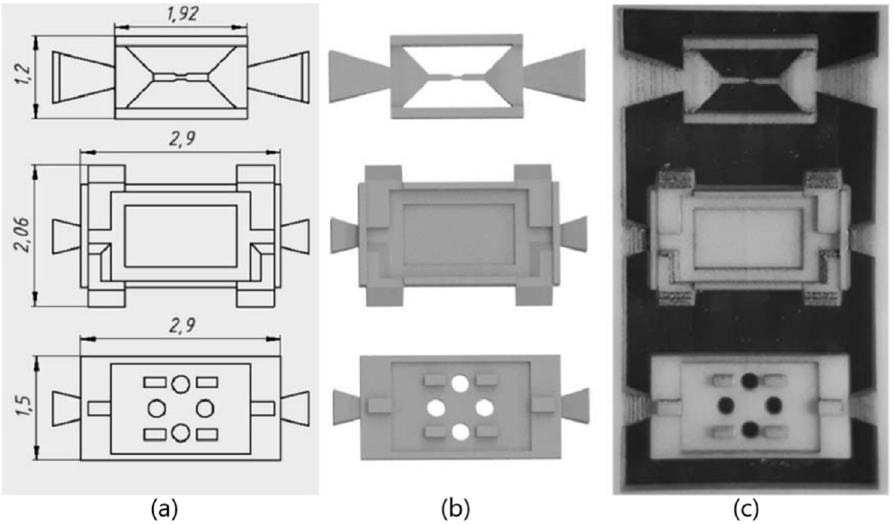
Figure 1. ( a ) Sketch with dimension in mm for parts of MEMS microhotplate (on top) and SOT-23 package (in bottom); ( b ) 3D model of sketch as screenshot in CAD program; ( c ) Parts of MEMS and SMD package after laser micromilling by using 3D models of MEMS.